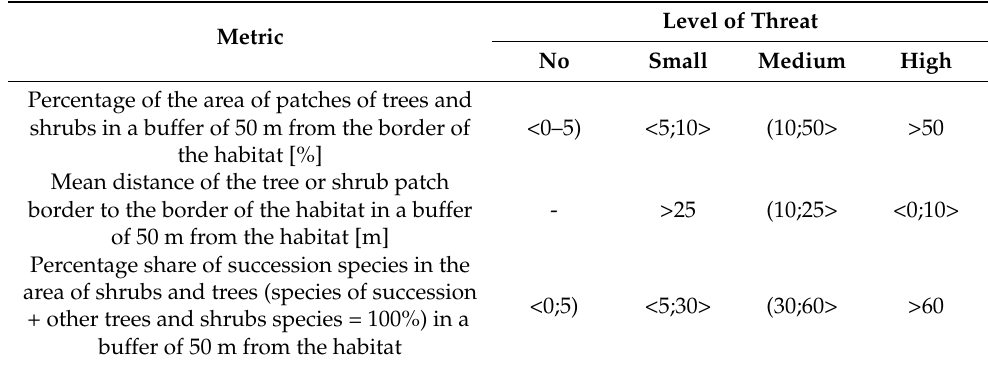
Table 5. The criteria used to define the levels of external threat of succession for selected individual habitats. Metric